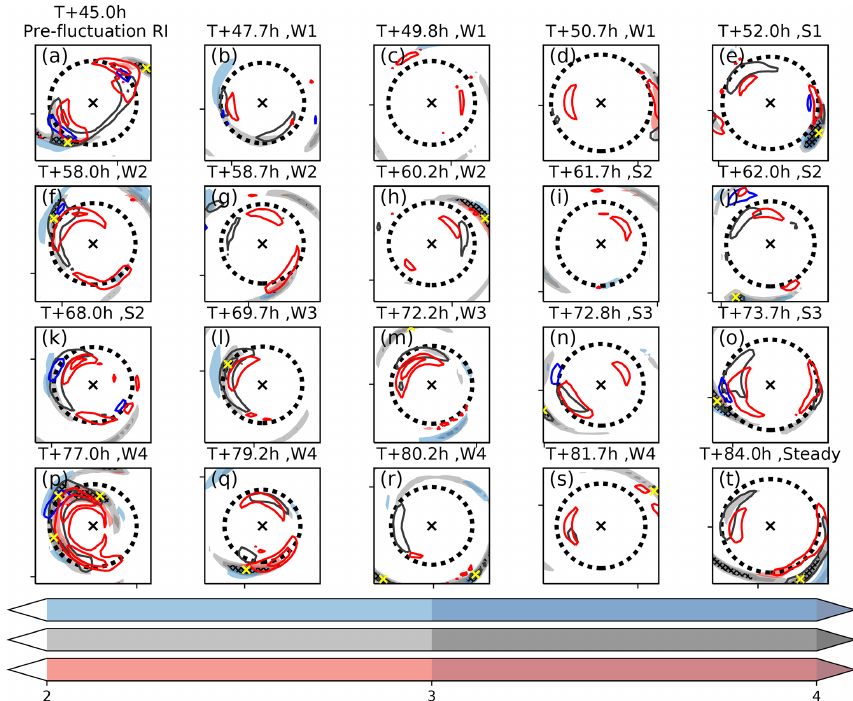
Figure 9. Perturbation vertical velocity (ms − 1 , shaded relative to the azimuthal mean) and perturbation relative vorticity (10 − 3 s − 1 , coloured line contours) shown at the same times as in Fig. 5. Heights shown are 2532m for the red shades/lines, 4963m for the grey shades/lines, and 9934m for the blue shades/lines. The centre of the TC is denoted by the cross, and the RMW at 4963m is indicated by the black dashed line. Black hatches represent regions where the maximum perturbation vertical velocity at any level exceeds 5ms − 1 . Yellow crosses show the locations of locally high perturbation relative vorticity at 4963m to indicate the location of isolated regions of deep rotating